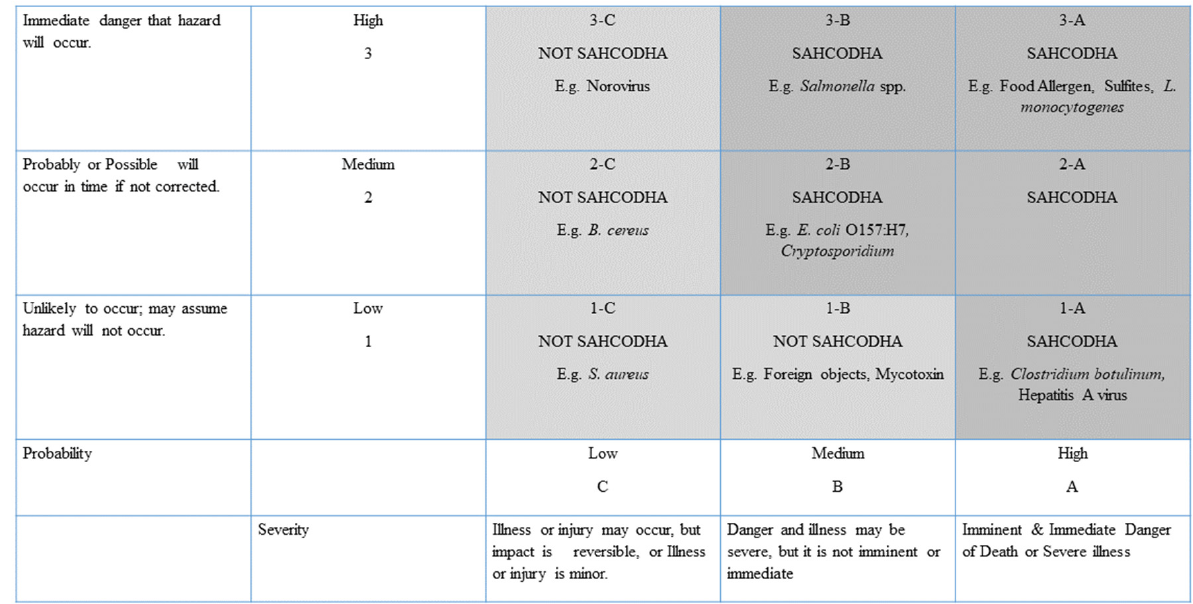
Figure 1. Fruit and vegetable 3 × 3 reference food safety risk matrix model. Exposure data can be interpreted as probability [23], while hospital and death data are used for the severity score. Each hazard’s significance level was used for final deci- sion